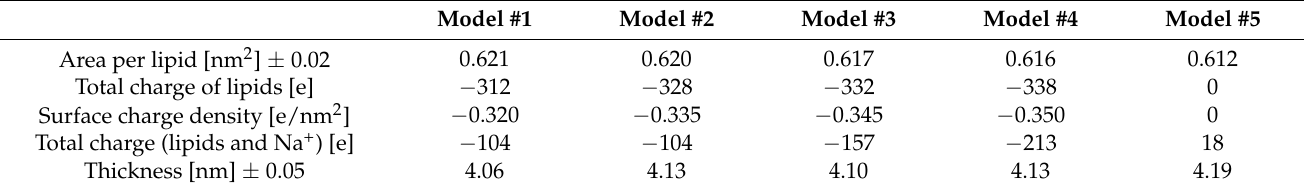
Table 2. Area per lipid, membrane thickness, charge carried by bilayer, and surface charge density.